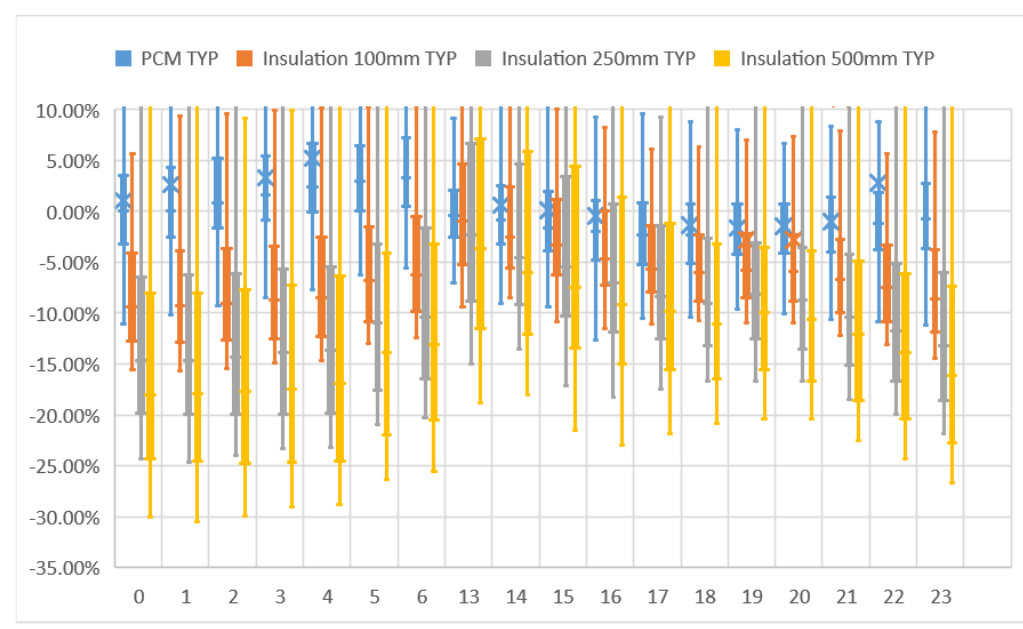
( a ) Box charts for hourly percentage difference in a year for tests for Typical Floor, (1) PCM; (2) 100 mm Internal Insulation; (3) 250 mm Internal Insulation; (4) 500 mm Internal Insulation. Figure A2.